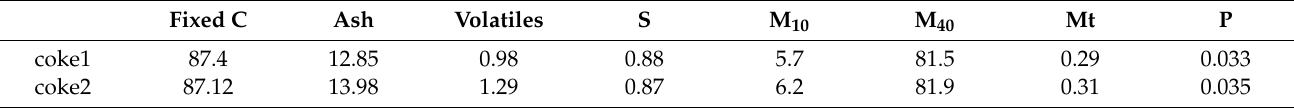
Table 2. Characteristics of the coke used in this work